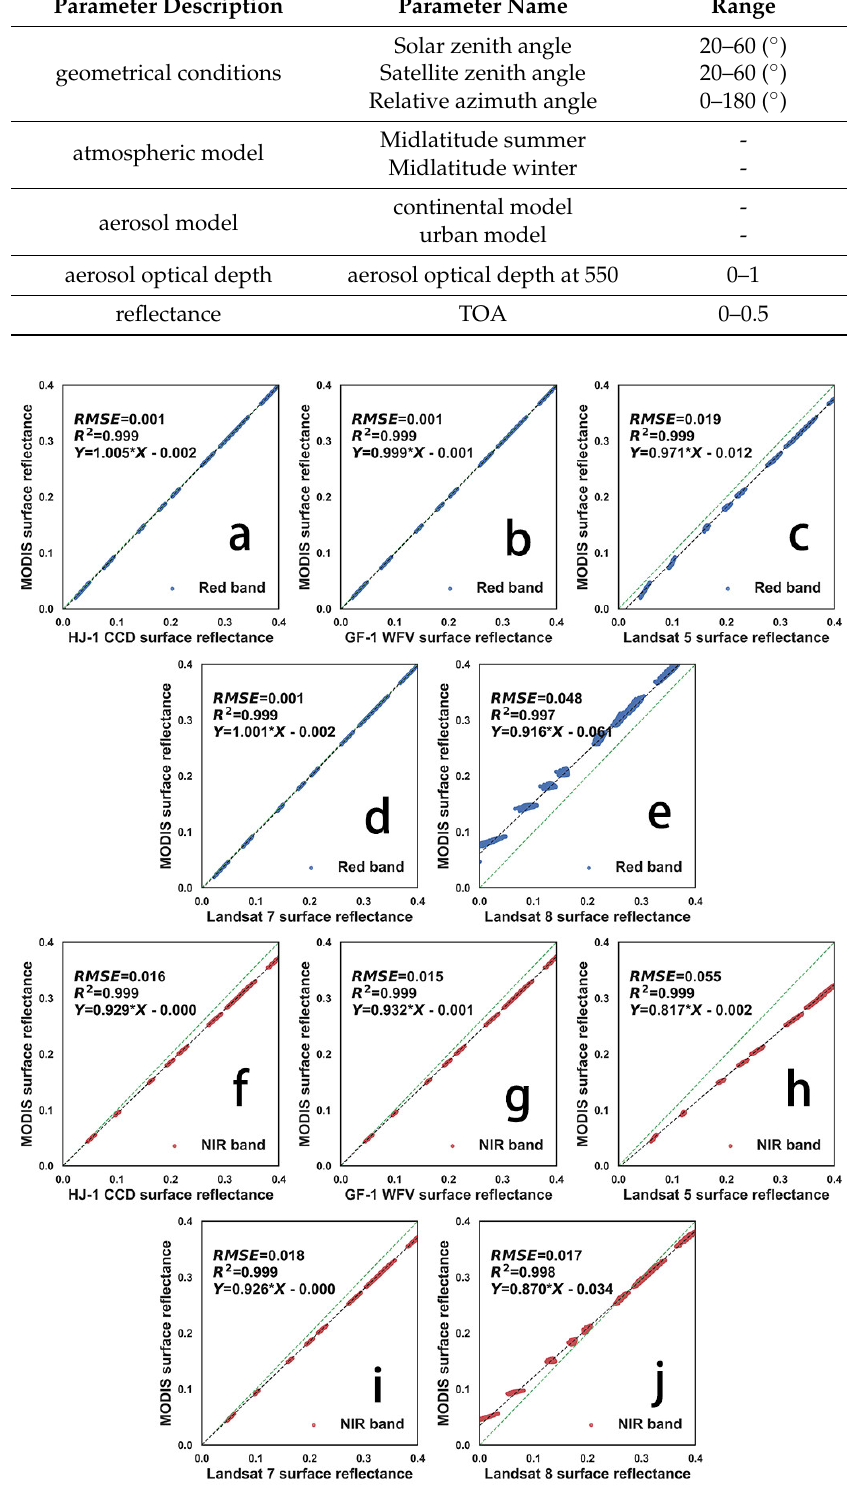
Figure 5. The relationships between Moderate Resolution Imaging Spectroradiometer (MODIS) surface reflectance and high resolution (HR) surface reflectance in the red and near-infrared (NIR) bands. ( a – e ) Surface reflectance in the red band; ( f – j ) surface reflectance in the NIR band. The composite method of the HR dataset is based on the generation algorithm of the MOD09 products. For each pixel, a value is selected from all acquisitions within the 8-day composite period. The criterion for the pixel choice is that the HR surface reflectance data are the minimum-blue [53,54]. The surface reflectance values of each of the different bands for the same location and day are copied to the composite image files using minimum blue criteria. The composite HR data not only reduces the inconsistency between the two data due to cloud contamination, but also reduces the difference in reflectance between the data, which facilitates the training of the neural network to retrieve a smooth LAI. 4. Results 4.1. 2013 and 2014 LAI Estimations from Satellite Data